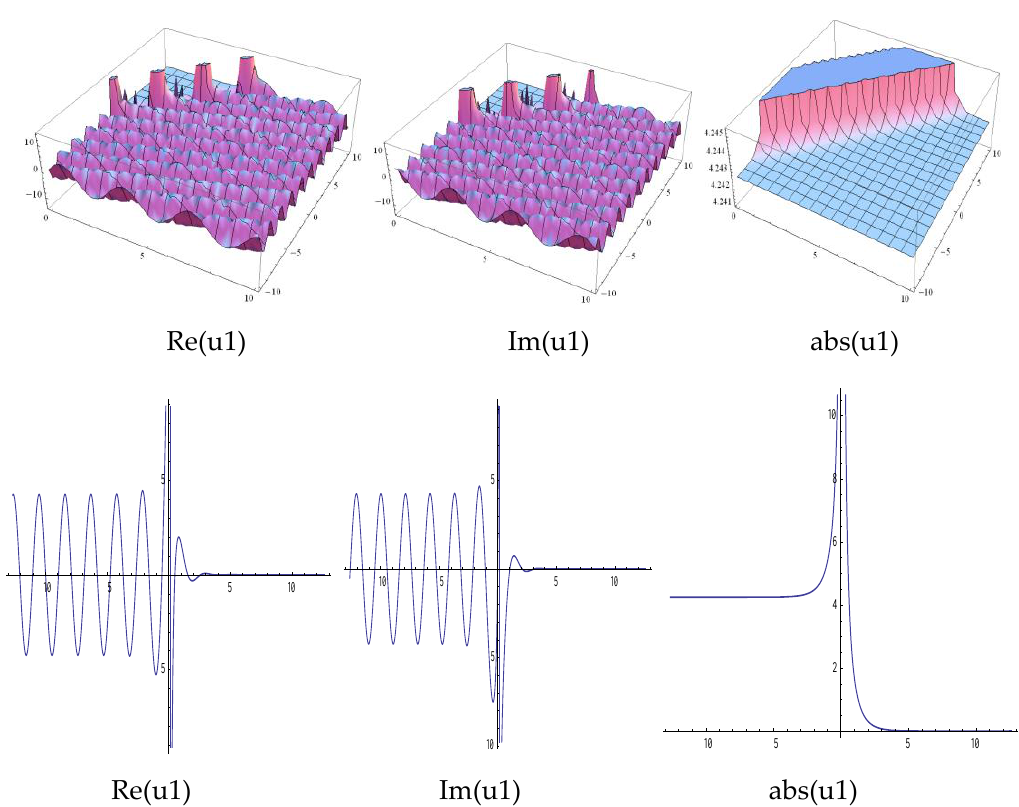
Figure 5. Solitary wave solution (51) of Equation (2) and its projection at 𝑡 = 0 when 𝐴 = −1, 𝐶 = 2, 𝑘 = 3,𝑝 = 2, 𝑞 = 0.5,𝜔 = 1, 𝑟 1 = 3,𝐴 1 = 5, 𝐴 2 = 6.